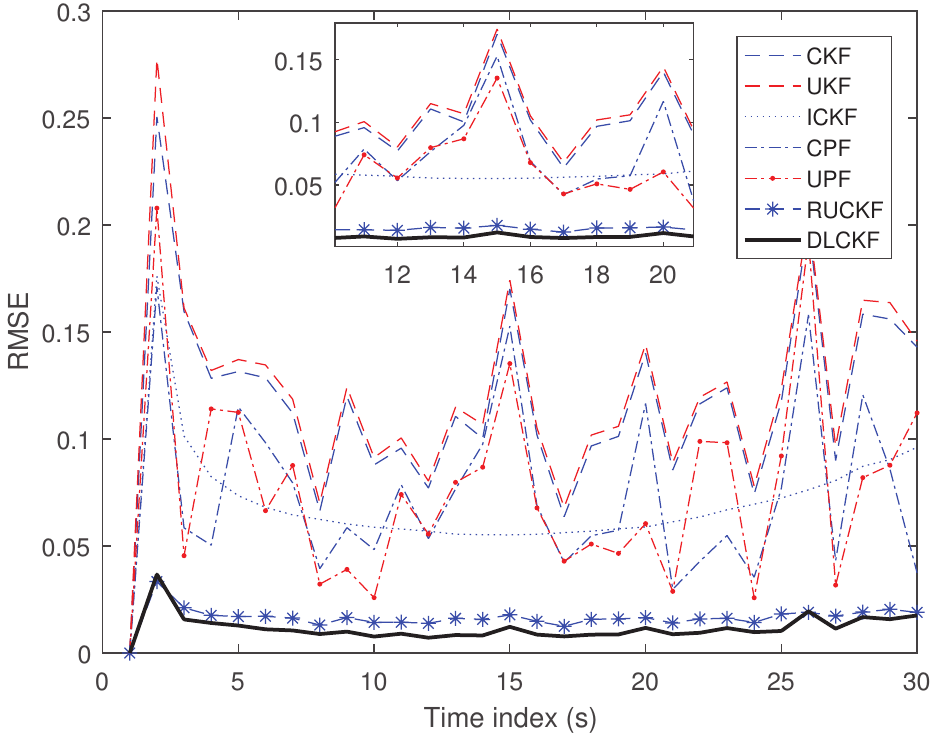
Figure 2. RMSE of 300 Monte Carlo